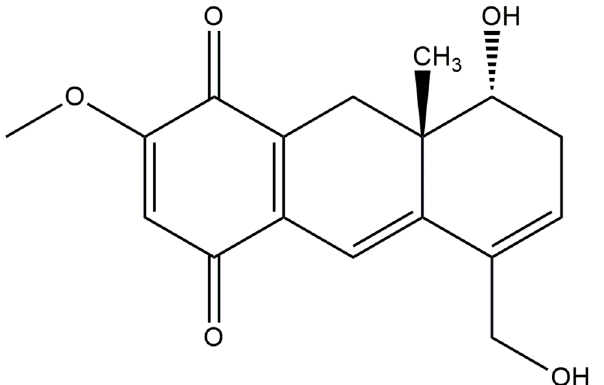
Fig 1. Chemical structure of Oncocalyxone